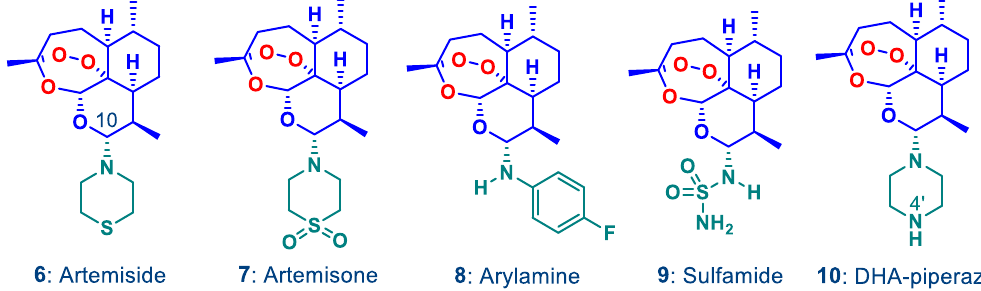
Figure 2. Amino-artemisinins bearing alkylamino, arylamino and sulfonylamino groups attached to C-10 of the artemisinin nucleus wherein the oxygen atom at C-10 in the current artemisinins (Figure 1) is replaced by the nitrogen atom. In terms of cost of goods, compounds 8 – 10 are the most economically obtained from DHA. The intent of the current work is to develop new compounds by attaching polar groups to N-4 in the piperazine derivative 10 .